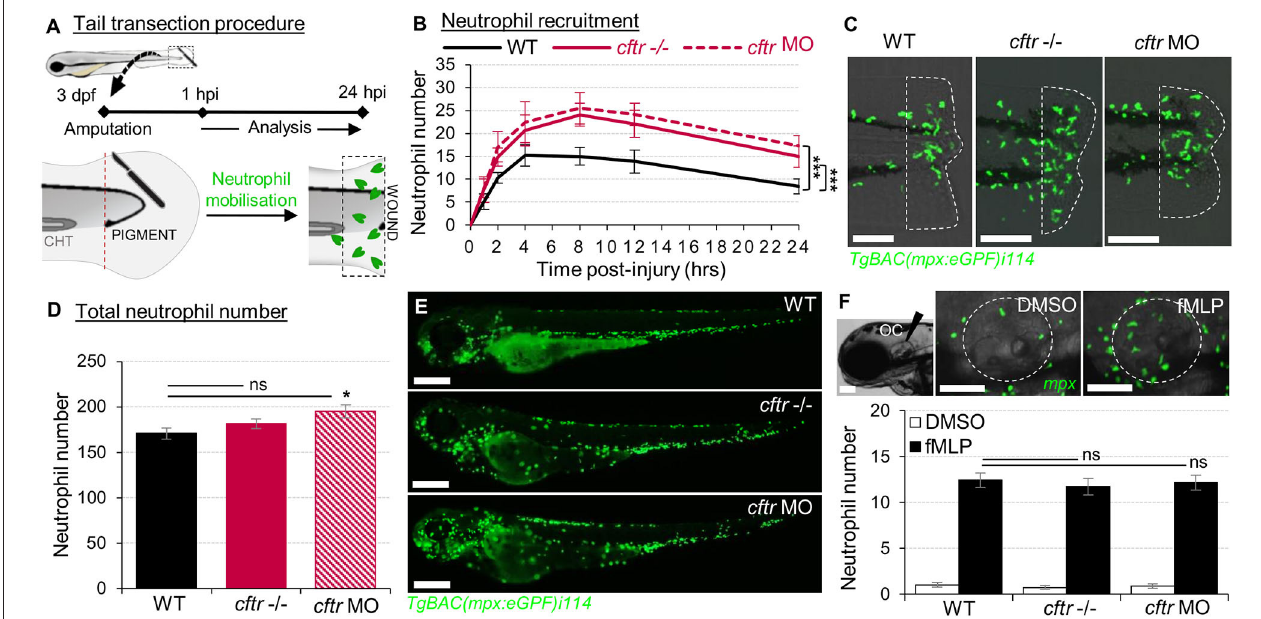
FIGURE 1 | Sterile injury-induced neutrophilic inflammatory responses are exacerbated in the absence of CFTR. (A–C) Neutrophil chemotaxis to sterile tissue lesions in WT, cftr –/– mutant ( cftr –/–) and cftr morphant ( cftr MO) TgBAC(mpx:EGFP)i114 zebrafish larvae. (A) Larvae were tail amputated then the number of neutrophils mobilized to the site of injury (dotted lines) has been observed and counted by fluorescent microscopy throughout inflammation. The wound area is defined as the region between the amputation edge and caudal hematopoietic tissue end (CHT). (B) Dynamics of neutrophil recruitment towards the wound over 24h ( n = 30; two-way ANOVA with Tukey post-test). (C) Representative confocal images of injured tails at 4 hpi (scale bars, 200 µ m). (D,E) Total number of neutrophils (D) in whole TgBAC(mpx:EGFP)i114 larvae ( n = 18; one-way ANOVA with Dunnett’s post-test). (E) Microscopy revealed a disorganized neutrophilic distribution in CFTR-depleted animal compared to control counterpart (scale bars, 200 µ m). (F) Neutrophil mobilization into the otic cavity (oc, dotted lines) in response to DMSO or fMLP injection in TgBAC(mpx:EGFP)i114 larvae monitored at 2 h-post injection. Representative photomicrographs of fMLP-injected animal compared to DMSO-injected control (top panel; scale bars, 50 µ m). Neutrophil counts ( n = 18; one-way ANOVA with Dunnett’s post-test) (bottom panel). See also Supplementary Figure 1